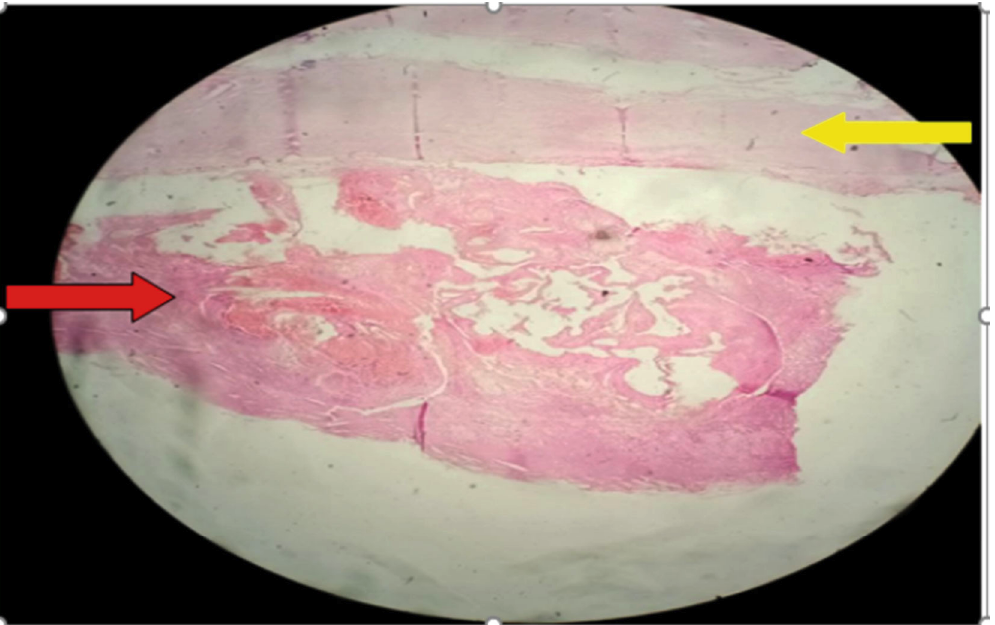
Figure 5: Low-power photomicrograph revealing fi brotic cyst wall (yellow arrow) and hyalinized pinkish cyst content (red